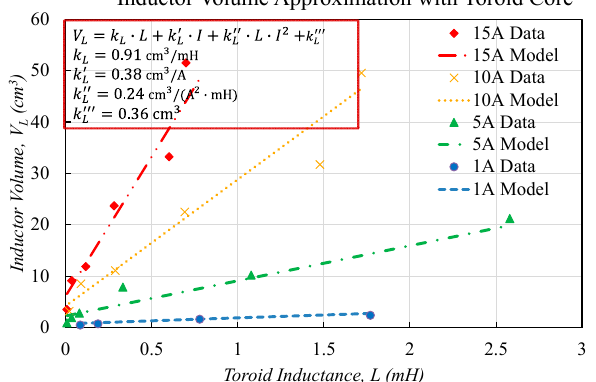
Figure 7. Proposed DM Inductor Volume Model.